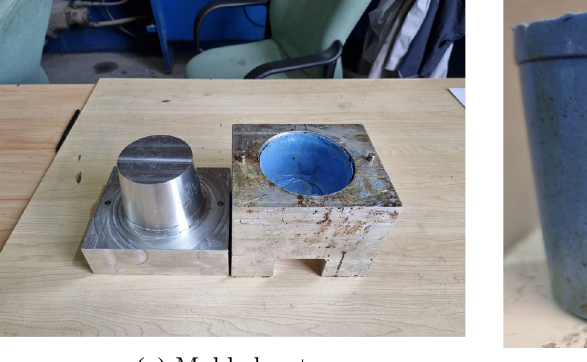
Fig. 20 The molding process